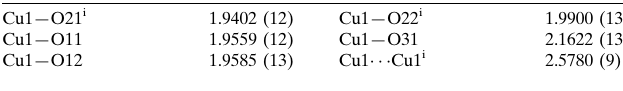
centrosymmetric dinuclear compound,